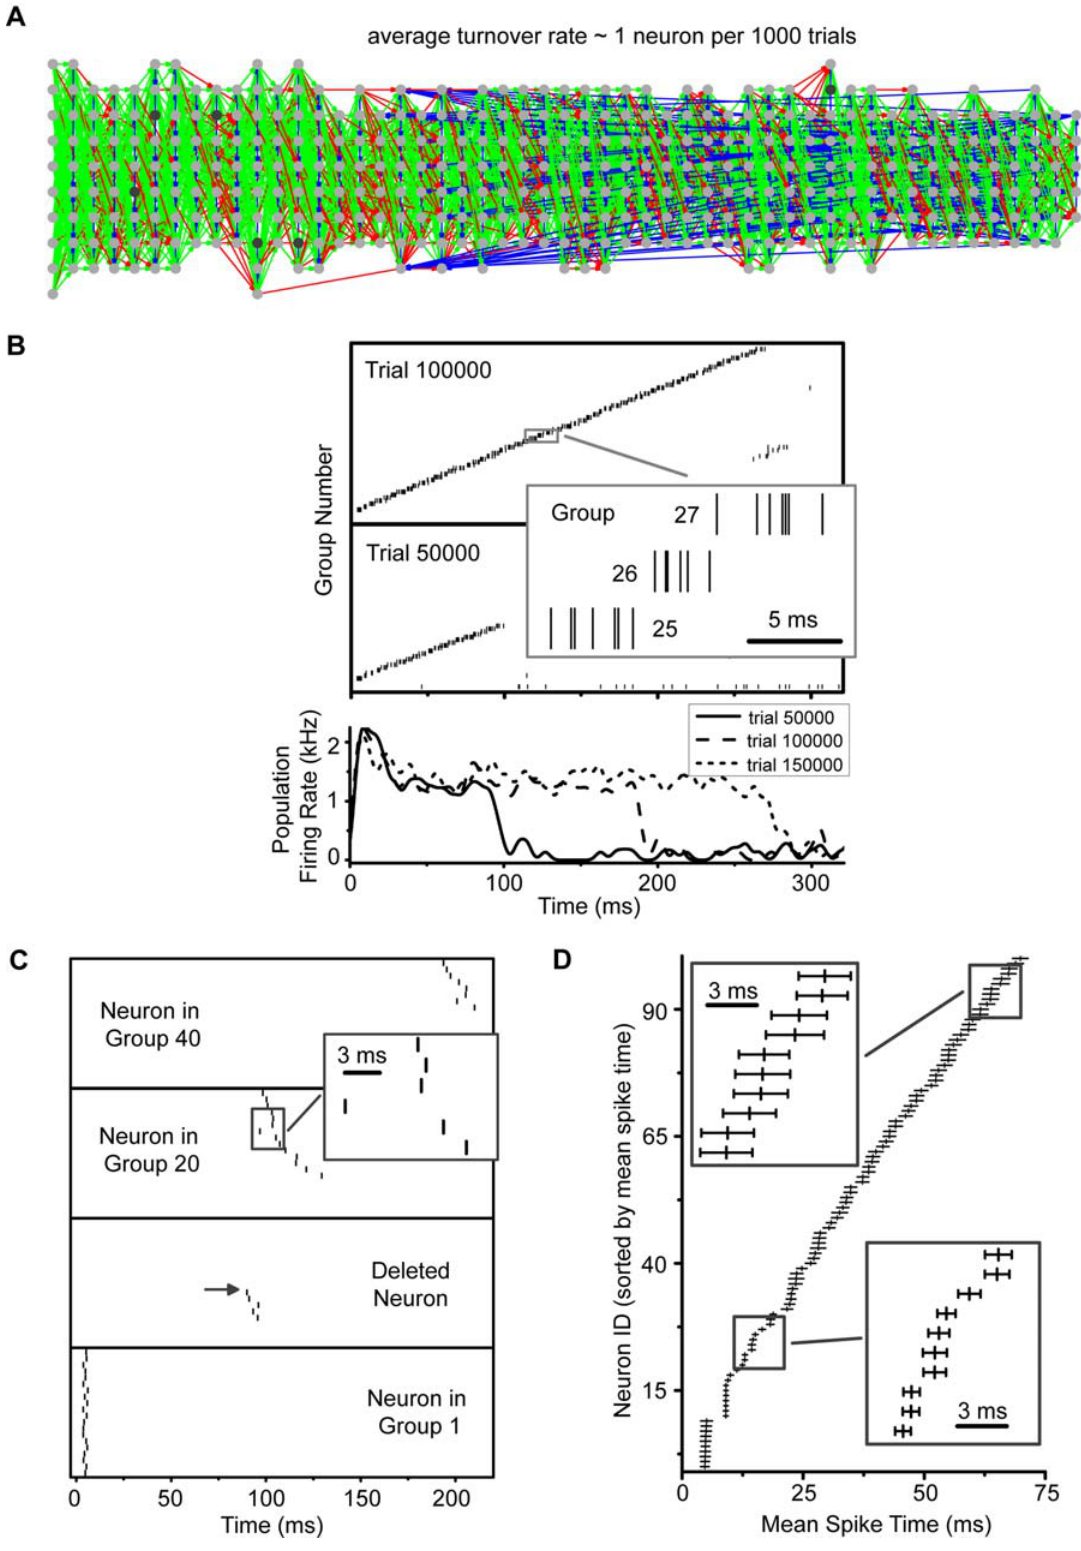
Figure 9. Network formation with turnover. (A) A network formed while neurons died and renewed at an average rate of 1 per 1000 trials through a Poisson process. Even with the turnover, the neurons were able to form a synfire network. (B) Population activity in single trials during the formation process are similar to those without turnover (Figure 4A). The duration of chain activity increases with the number of training trials. (C) Spikes of individual neurons across trials show different behaviors than those without turnover (Figure 4B). A recruited neuron can be deleted (second panel from bottom). Upstream neurons (three upper panels) can shift their spiking times forward as they fill slots vacated by deleted neurons in earlier groups. (D) Spike timings across 100 trials shows that neurons in the chain spike with accuracy on the order of ms.